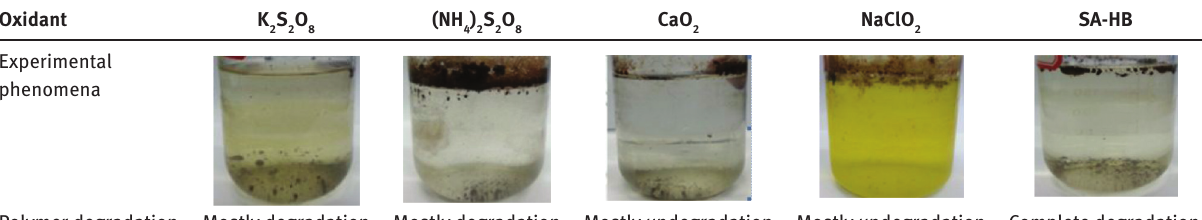
Table 6: Degradation effect of oxidant. Oxidant